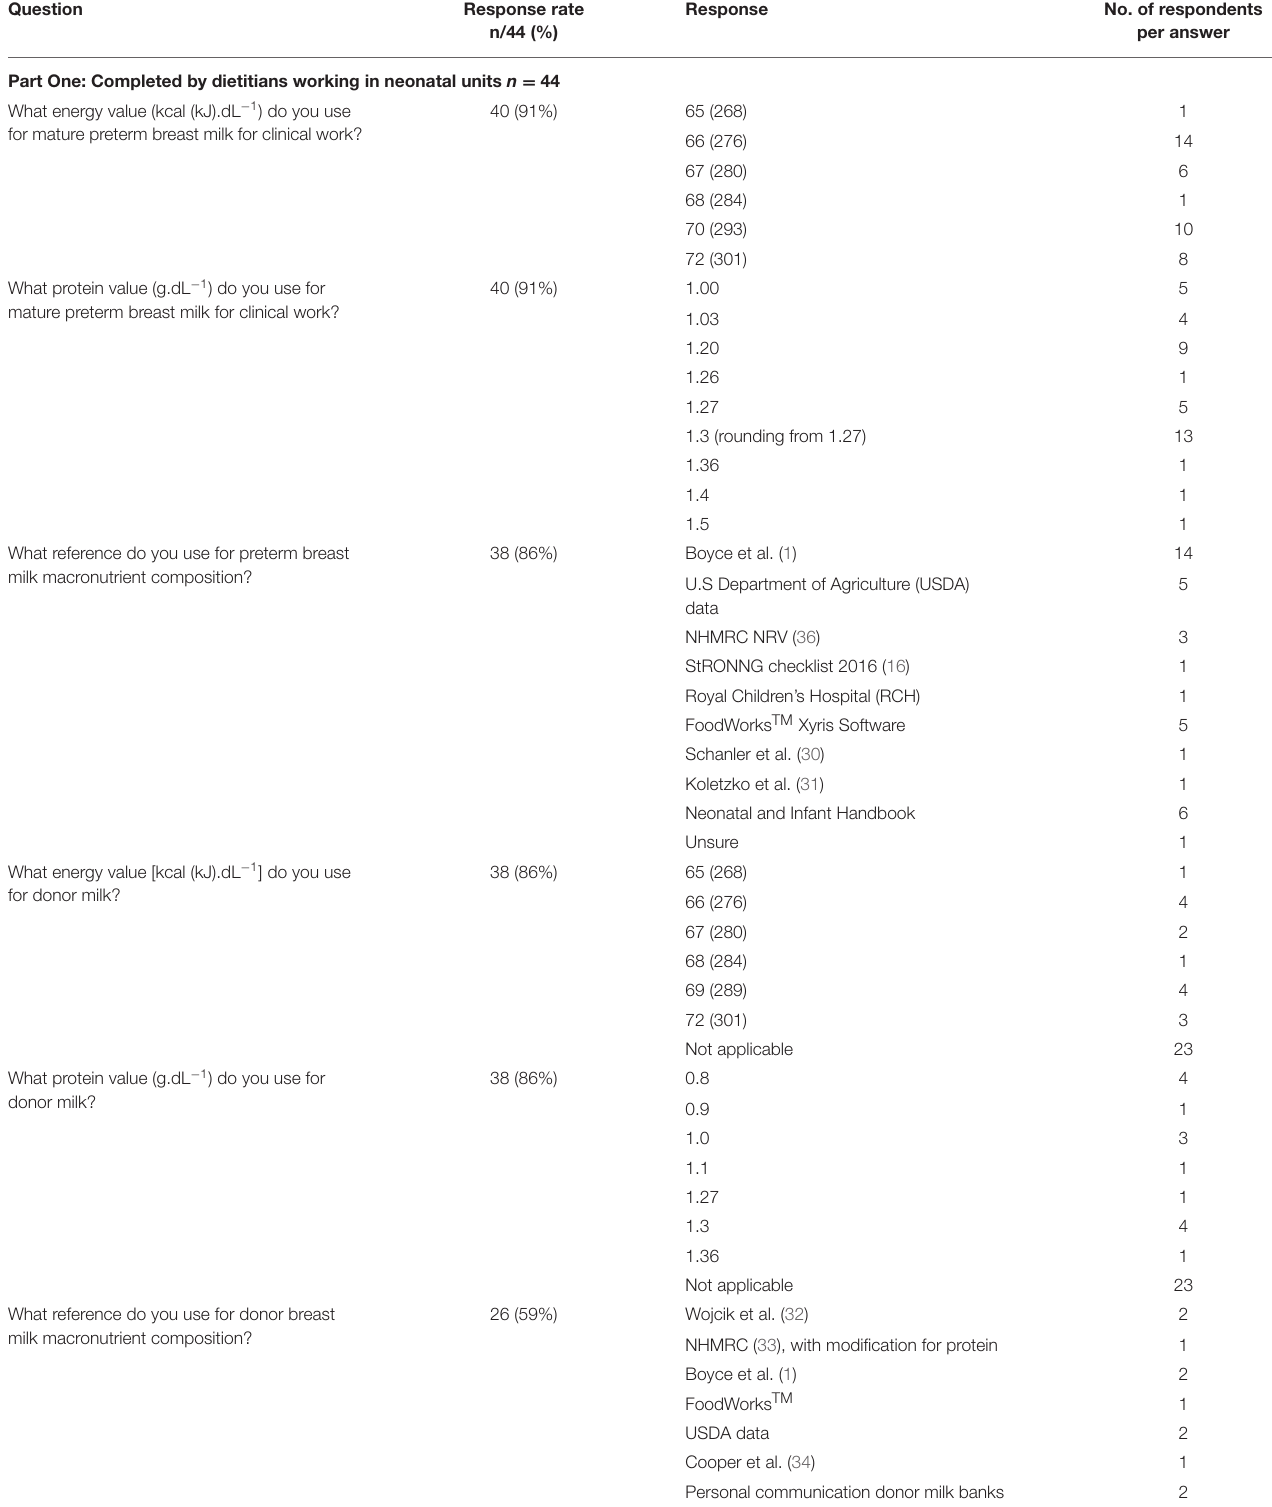
Response No. of respondents n/44 (%)